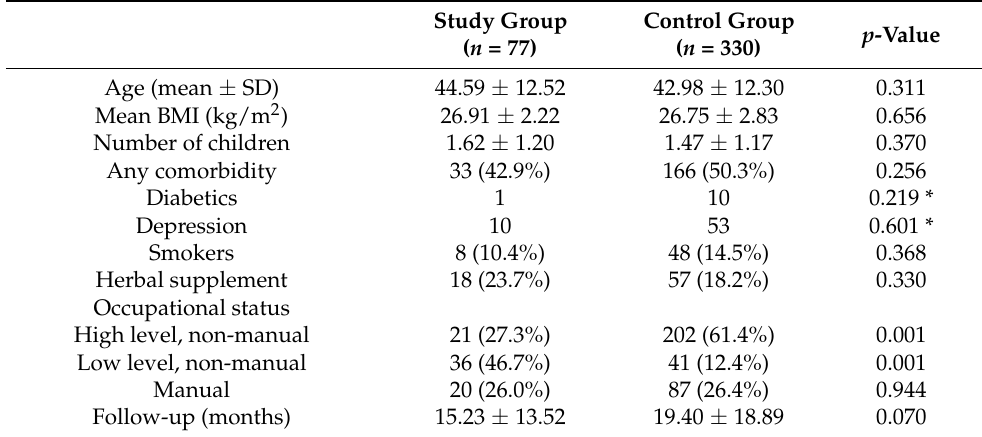
Table 1. Demographics of patients at time of study. Study group included patients who experience a prolonged sick leave versus the other ones.